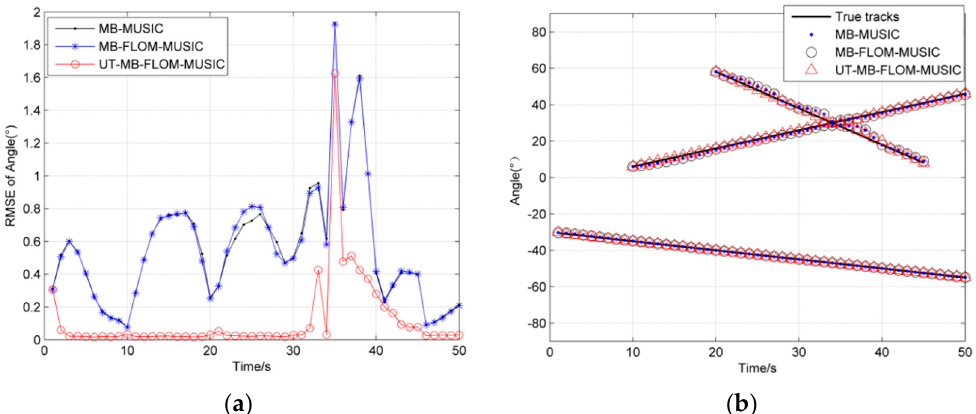
Figure 2. RMSE of angle under α = 1.3, L = 100 and GSNR = 10 dB: ( a ) The RMSE of 100 MC; ( b ) source trajectory of Single MC.